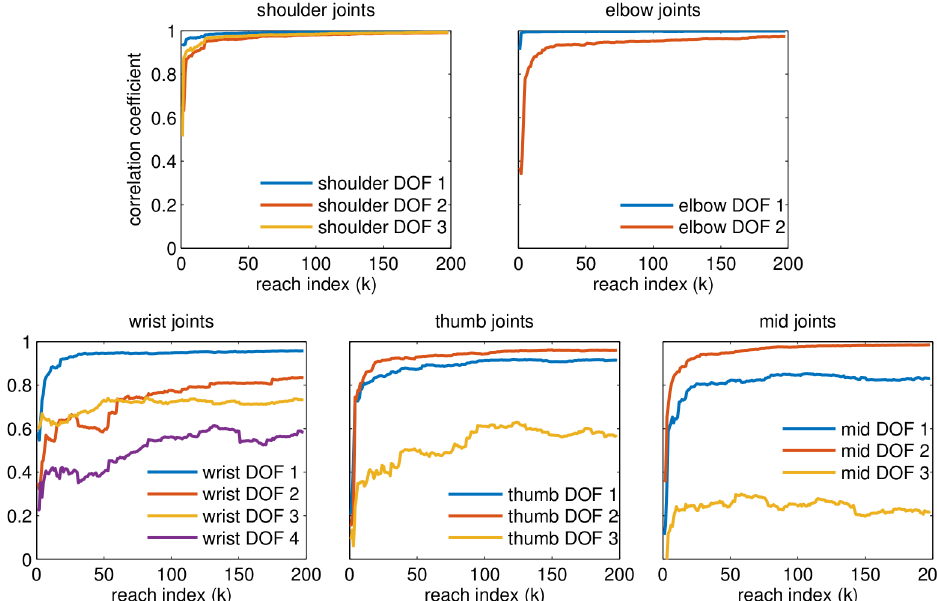
Fig 5. Panels depict correlation between “ true ” encoding model and estimated encoding model parameters as a function of index over reach trajectories (for a single trial). Each curve corresponds to the correlation for a different DOF. The encoding model parameters are not directly guaranteed to converge. We see, as expected, that the encoding model will improve for specific DOF in proportion to the extent to which those dimensions are relied on to perform the task. Shoulder DOF are crucial for the task, being implicated in most reaches, so are learned rapidly. Wrist and finger joints are relatively less critical for task performance, so are learned more gradually. In the thumb and middle finger panels above, the least well- learned DOF (thumb DOF 3 and mid DOF 3) can be interpreted as the “ distal inter-phalangeal joint ” (i.e. the small joint near tip of the finger), which is not heavily relied upon in this reach